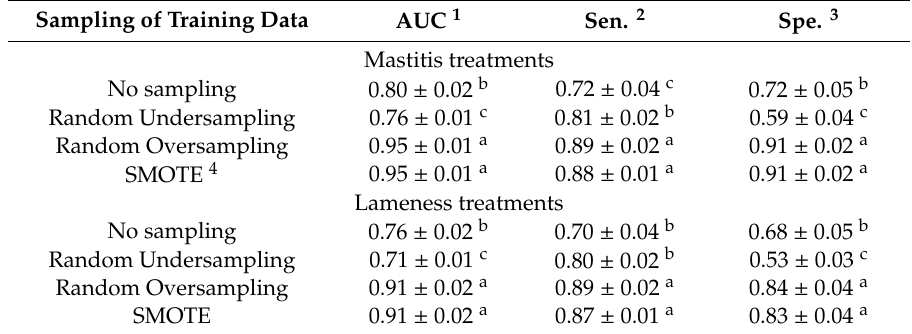
Table 4. Mean AUC, Sensitivity and Specificity ( ± 95%-CI) for validation data (33% of sampled training data), means for all machine learning